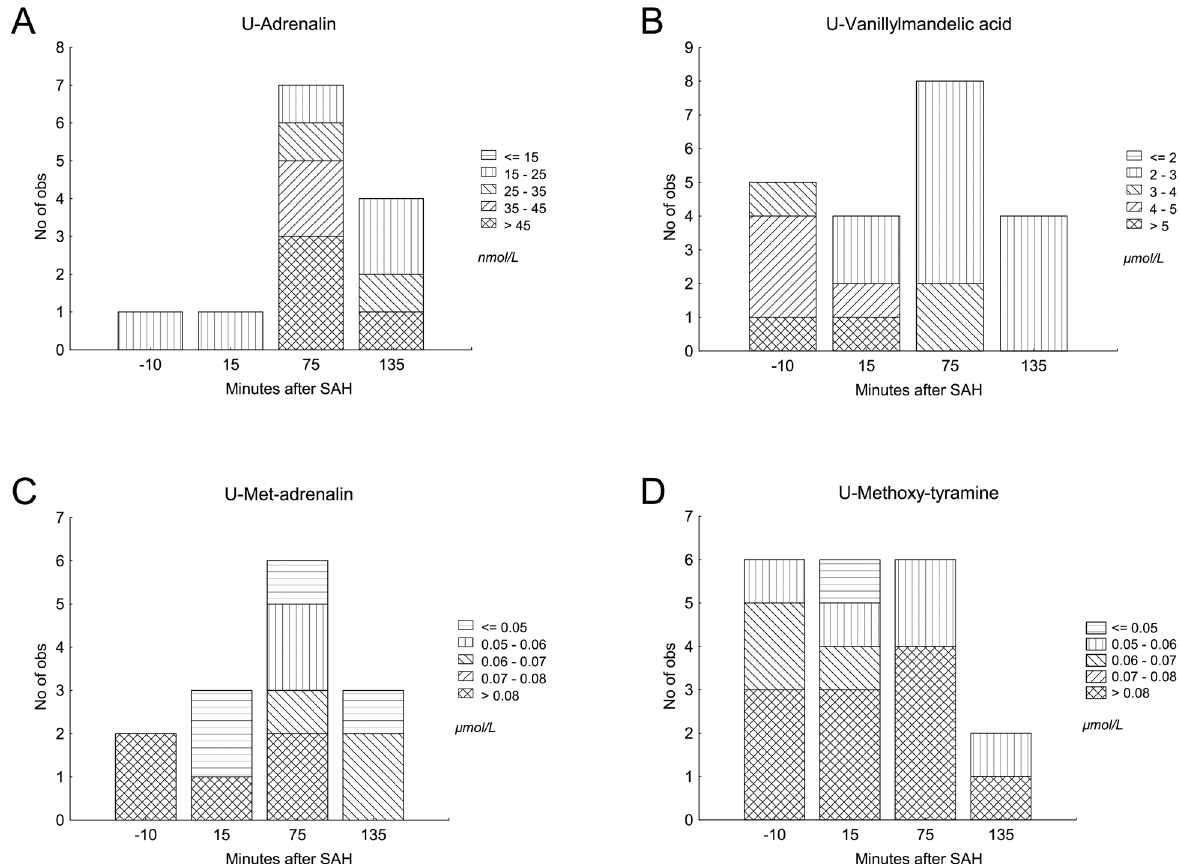
Fig 2. Catecholamines in urine. Catecholamines and metabolites in urine in animals with transient ischemia. Samples with detectable concentrations are shown.